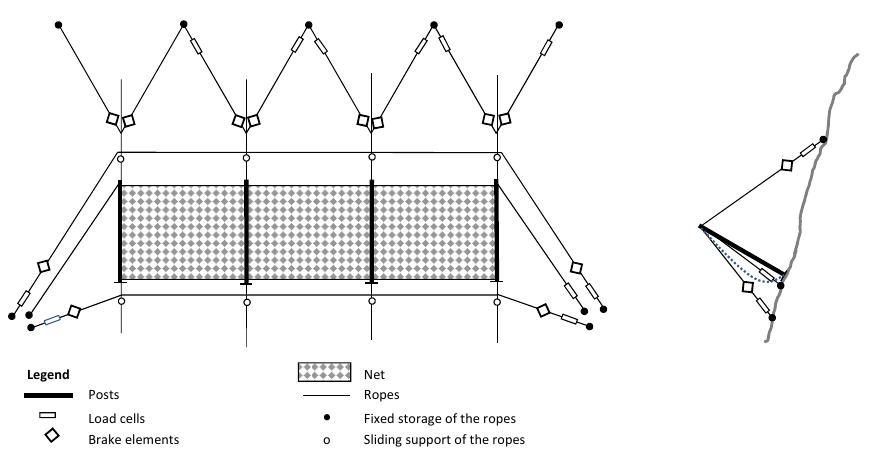
Figure 1. Schematic structure of a flexible rockfall protection system spanning three fields (frontal and side